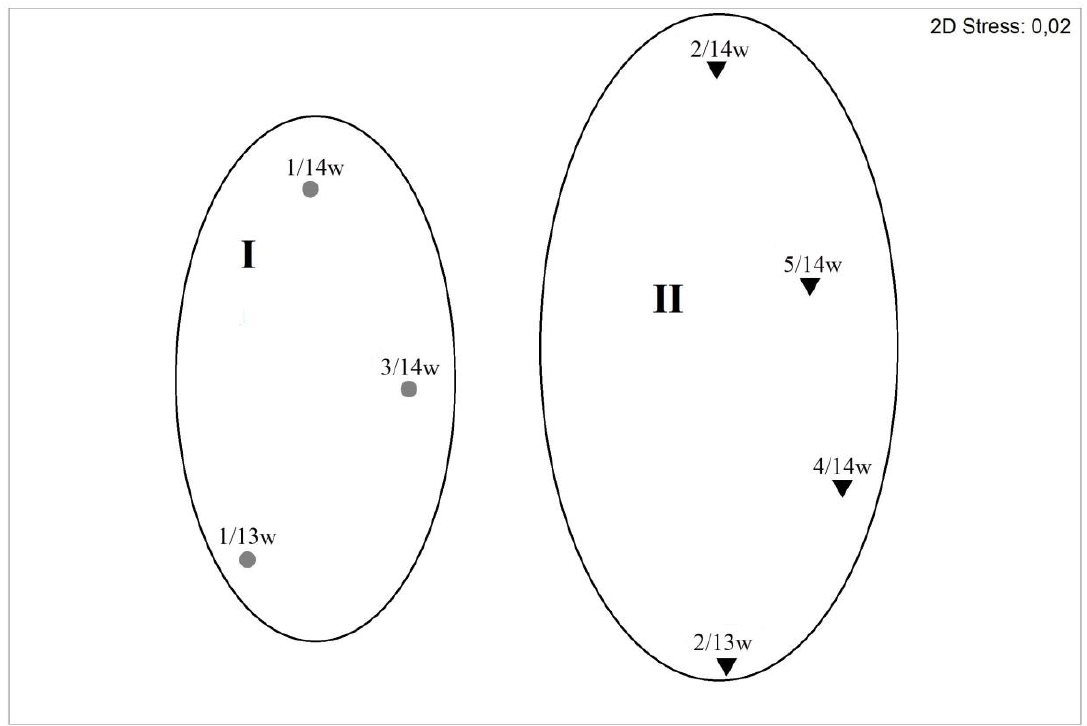
Figure 6. Community comparison of PPE assemblages at the different sampling stations using nonmetric multidimensional scaling (MDS) of a data matrix based on Bray‒Curtis similarity.